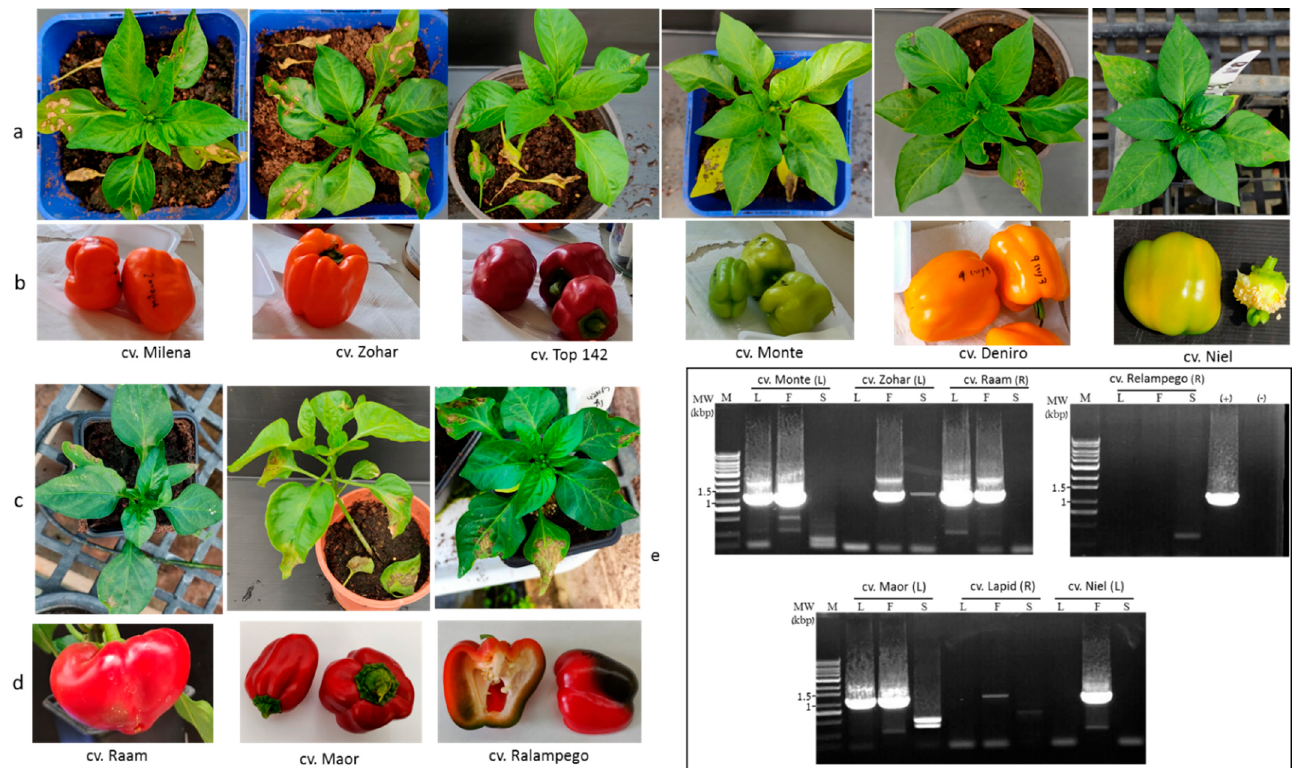
Figure 4. Dissociation between ToBRFV transient infection and disease symptom manifestations on fruits of L 1 , L 3 , and L 4 pepper plants: ( a , c ) leaf-infected plants showed HR manifestations on inoculated leaves; ( b , d ) asymptomatic fruits collected from each of the tested cvs.; ( e ) ToBRFV-infected fruits were not seed-infected, excluding L 4 Zohar seeds, as analyzed by double RT-PCR (see Materials and Methods) using primer set number (8); L, leaf; F, fruit; S, seeds; (L), leaf-inoculated; (R), root-inoculated; M, molecular size marker; (+) positive control; ( − ) negative reaction control. Fruits collected at early pickup stages from several pepper plants harboring the L gene were ToBRFV positive (Figure 5(a2,b2)). ToBRFV ELISA-positive fruits were found at either 105–214 dpi (Figure 5(a2), first and second collection stages) or 61–108 dpi (Figure 5(b2), first, second, and third collection stages). Several cultivars had a high percentage of infected fruits such as L 1 Maor, L 3 Monte, L 4 Zohar, and L 4 Ralampego, and two cultivars, L 3 Niel and L 4 Raam, had infected fruits at a late dpi stage. Those cultivars and L 1 Lapid were tested by double RT-PCR (see Materials and Methods) for seed infection (Figure 4e). Although leaves and fruits were ToBRFV-infected, RT-PCR data showed that excluding seeds of an infected fruit of a foliar-inoculated L 4 Zohar plant, seeds of infected fruits of foliar-inoculated cultivars L 1 Maor, L 1 Lapid, L 3 Niel, and L 3 Monte and of root-inoculated cv. L 4 Raam were not infected with ToBRFV (Figure 4e). Importantly, seeds of the two cultivars that were ToBRFV positive by using either the ELISA test ( L 4 Deniro) or RT-PCR ( L 4 Zohar) were negative in a bioassay performed on N. tabacum cv. Xanthi plants. These results indicate the detection of noninfectious virus in the seeds showing CP subunits of noncomplete virions or fragmented RNA. Fruit pericarps of all analyzed L 1 -, L 3 -, and L 4 -resistant cultivars, which were ELISA-positive at early collection stages, were ELISA- negative for ToBRFV at later fruit collection stages (Figure 5(a2,b2), pulled fruits). In addition, fruits of all tested cultivars harboring L 1 , L 3 , or L 4 resistance alleles during all collection stages were asymptomatic, indicating the dissociation between ToBRFV transient infections and disease symptom manifestations on the fruits (Figure